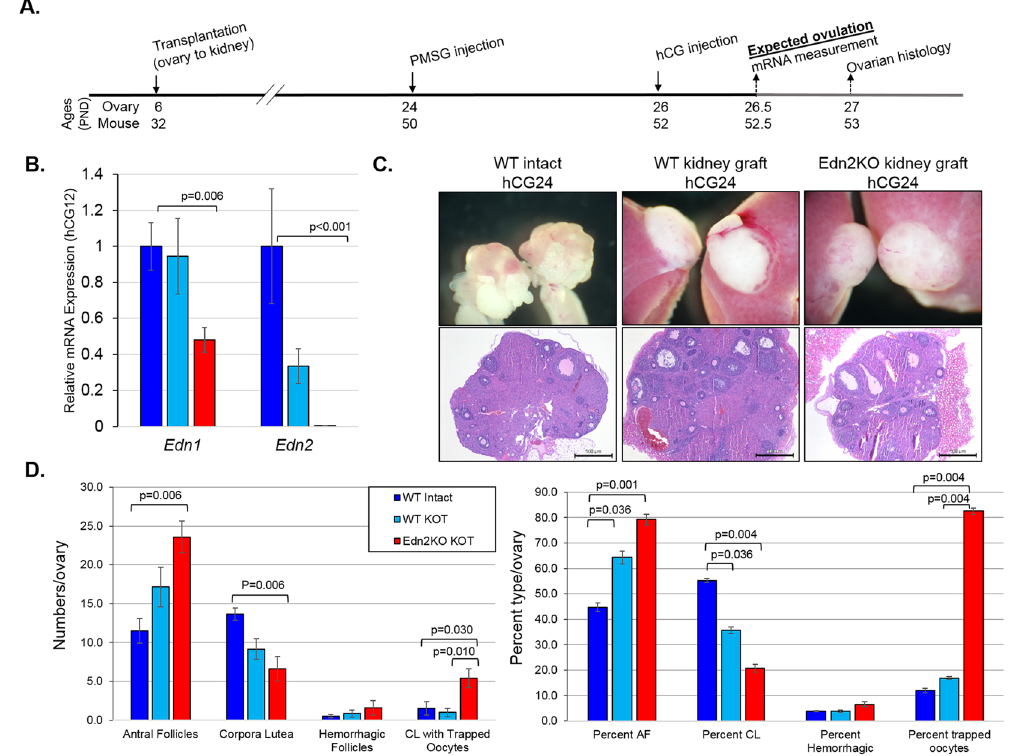
Figure 2. Edn2KO ovaries grafted under the kidney capsule have decreased ovulatory ability. ( A ) Experimental plan for WT and Edn2KO ovary grafting. Pups were euthanized at post-natal day 6 (PND6) and ovaries were grafted under the kidney capsule of 28–32 day old control females. Mice were then superovulated 18 days after transplantation and ovaries were collected. ( B ) Ovaries were collected at hCG12 hours; RNA was extracted and RT-PCR was performed for Edn1 and Edn2 expression to confirm gene loss. Grafted Edn2KO ovaries had significantly lower Edn1 (p = 0.006) and Edn2 (p < 0.001) expression than intact WT mice. Grafted WT ovaries trended towards decreased Edn2 expression (p = 0.086). ( C ) At hCG 24 hrs, ovaries were collected and serially sectioned. Images are shown grossly before removal from the kidney and at 4X. Grafted ovaries become flattened with a greater diameter and are less deep. Antral follicles, corpora lutea, and immature follicles were present in all groups. ( D ) Ovaries collected at hCG 24 hrs were serially sectioned. The total numbers of antral follicles (AF) and corpora lutea (CL) were determined (n = 5–7). Absolute counts are displayed at left and percentages are displayed at right. When compared to grafted WT ovaries, transplanted Edn2KO ovaries trended towards a higher percentage of antral follicles and fewer CL (p = 0.088). Grafted Edn2KO ovaries had significantly more oocytes trapped within corpora luteal (p = 0.010) and a significantly greater percentage of CL with trapped oocytes (p = 0.004). Errors bars represent the SEM. KOT = kidney-ovarian